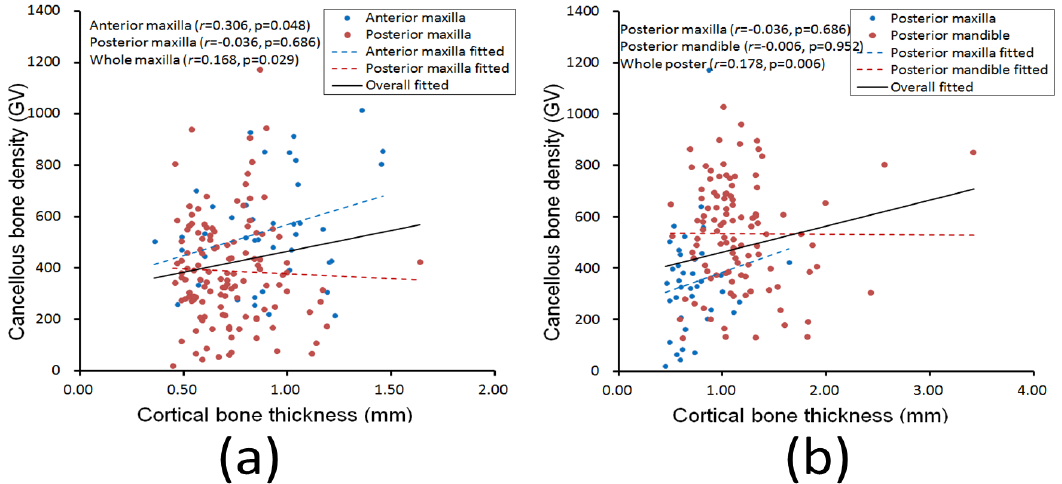
Figure 5. Relationships between cortical bone thickness and cancellous bone density at dental implant sites in the ( a ) anterior maxilla (blue dots and dotted line), posterior maxilla (red dots and dotted line), and the entire maxilla region (black line) and in the ( b ) posterior maxilla (blue dots and dotted line), posterior mandible (red dots and dotted line), and entire posterior region (black line).